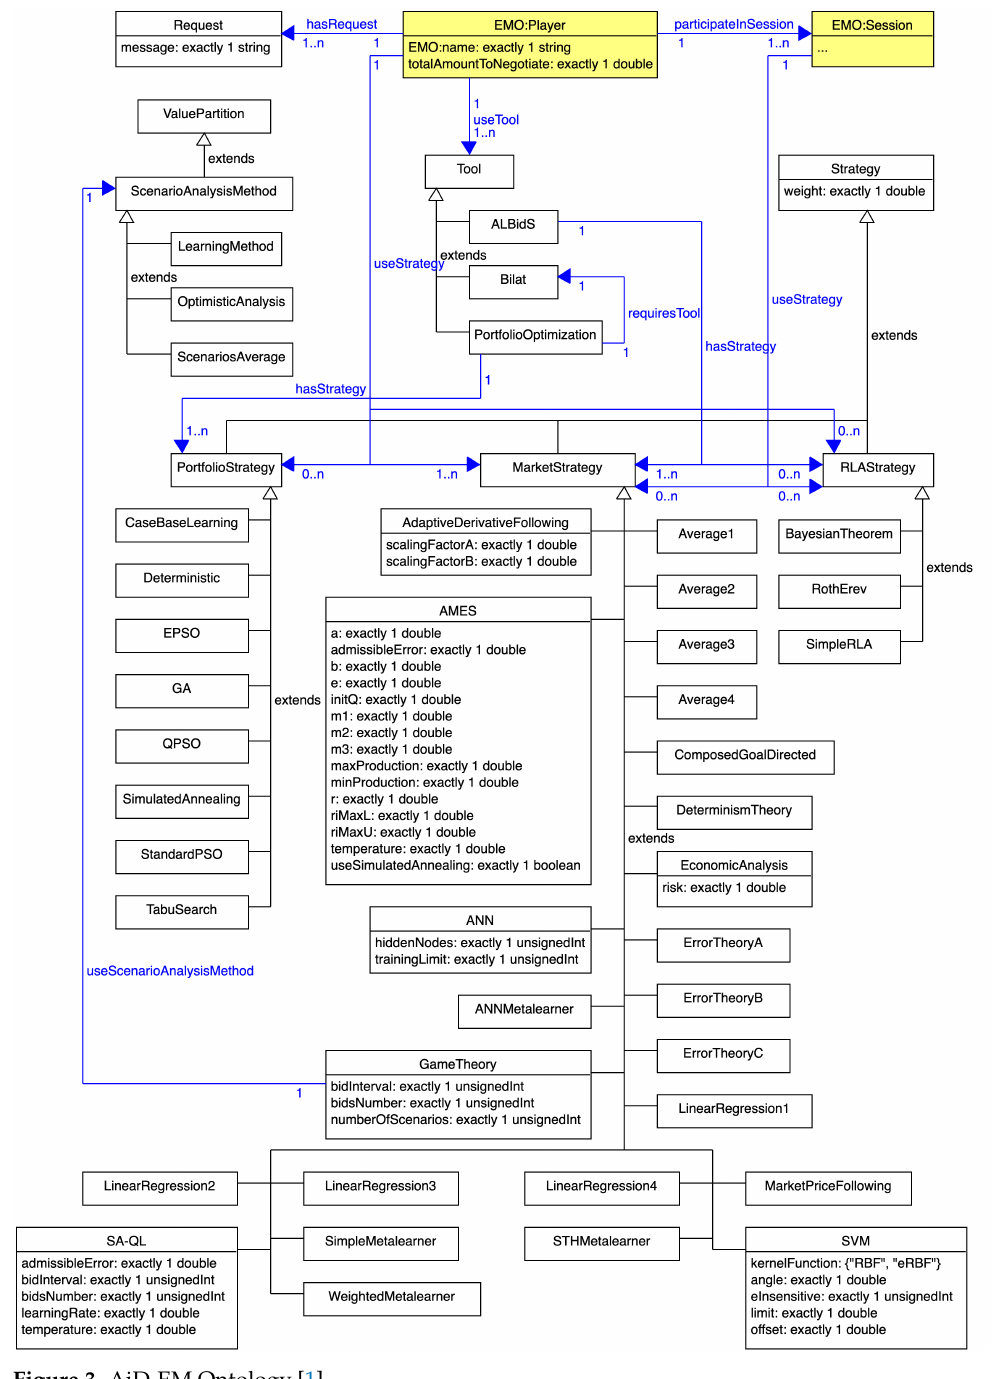
Figure 3. AiD-EM Ontology